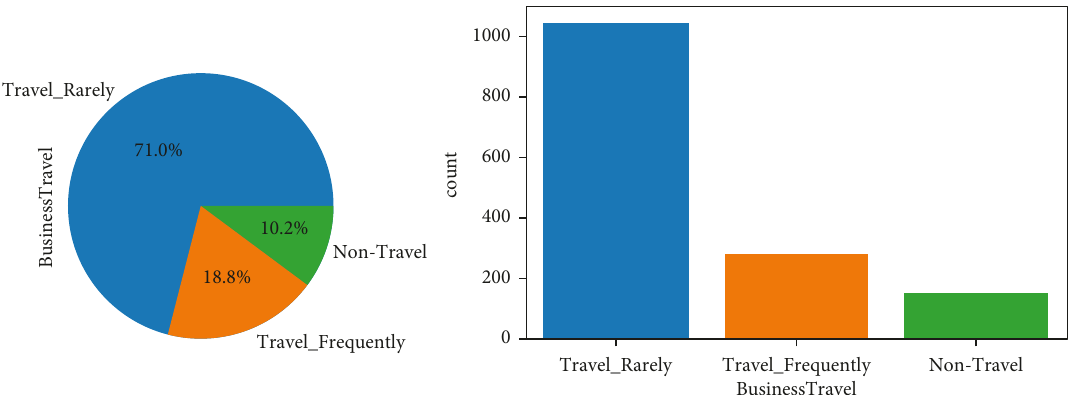
Figure 4: Distribution on the basis of travel readiness.